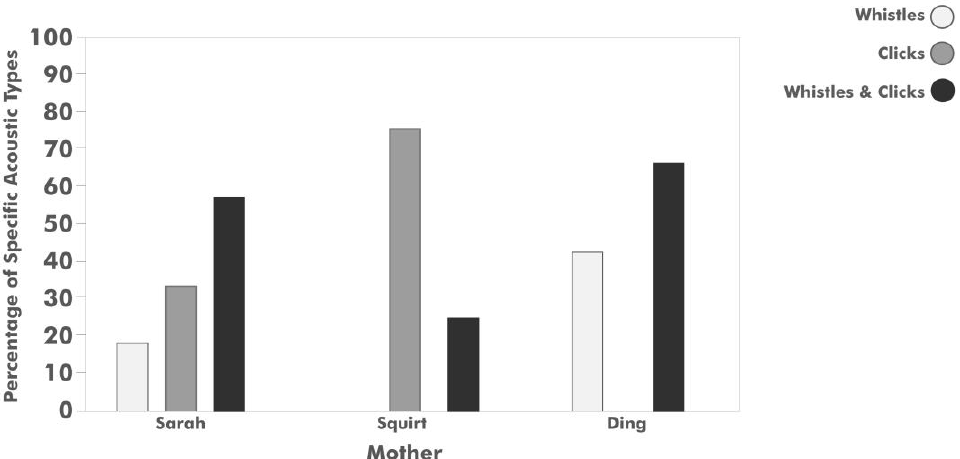
Figure 5. Relative percentage of specific acoustic types (whistles, clicks, or a combination of whistles and clicks) used by each mother in the calf retrieval